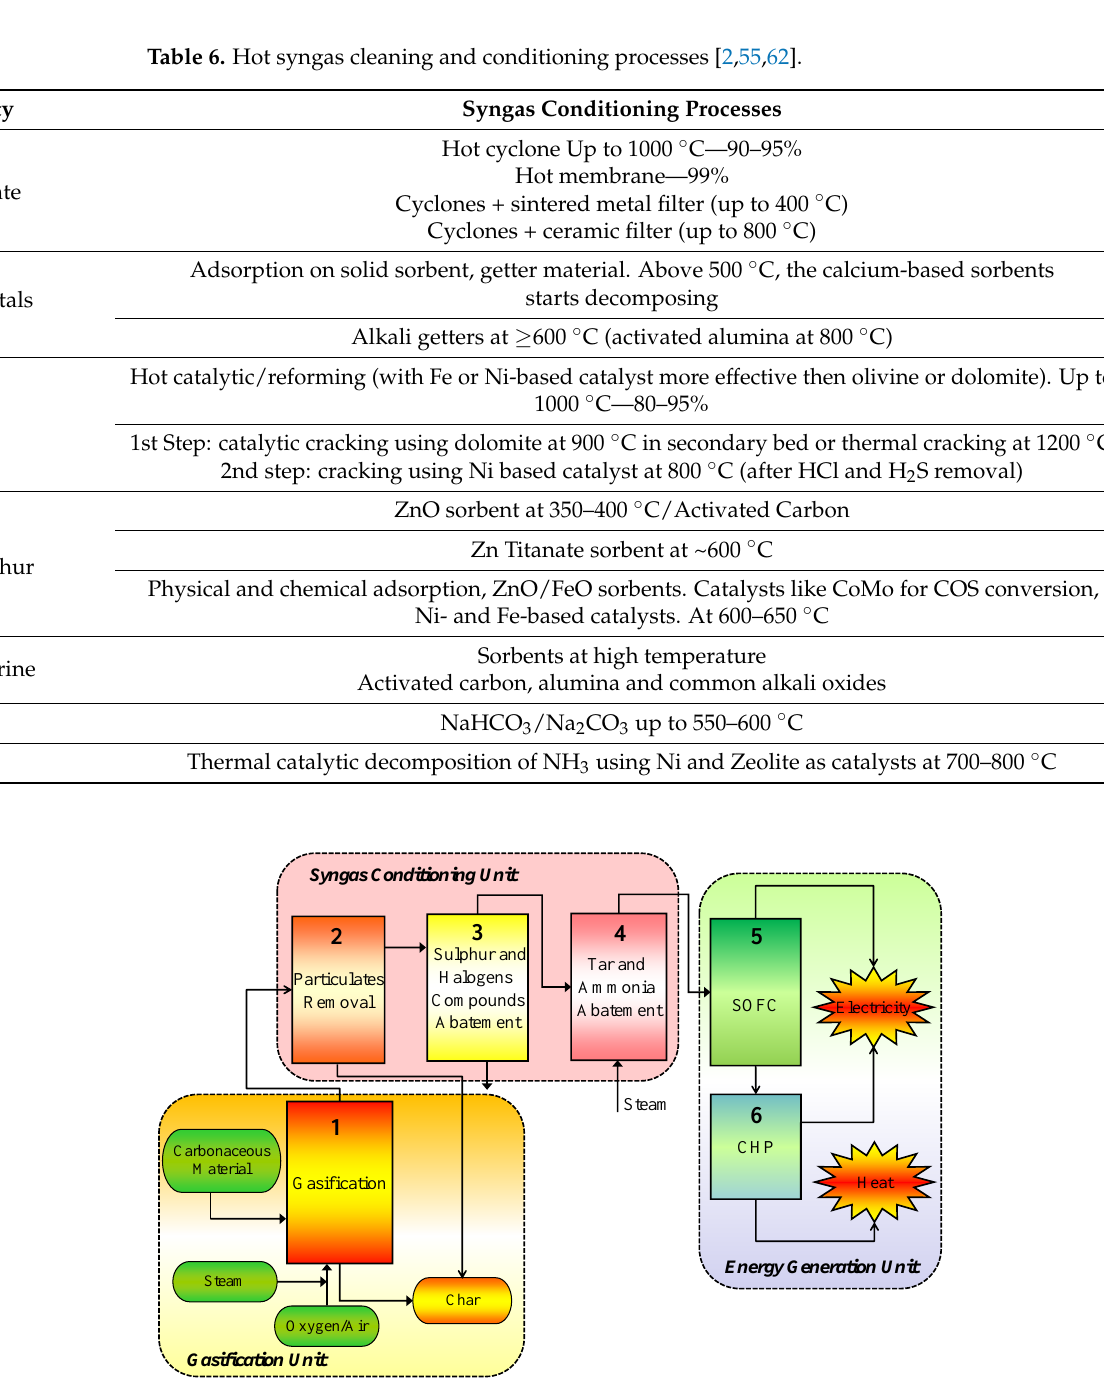
Figure 1. Proposal diagram for hot syngas cleaning and conditioning to be used in SOFC.